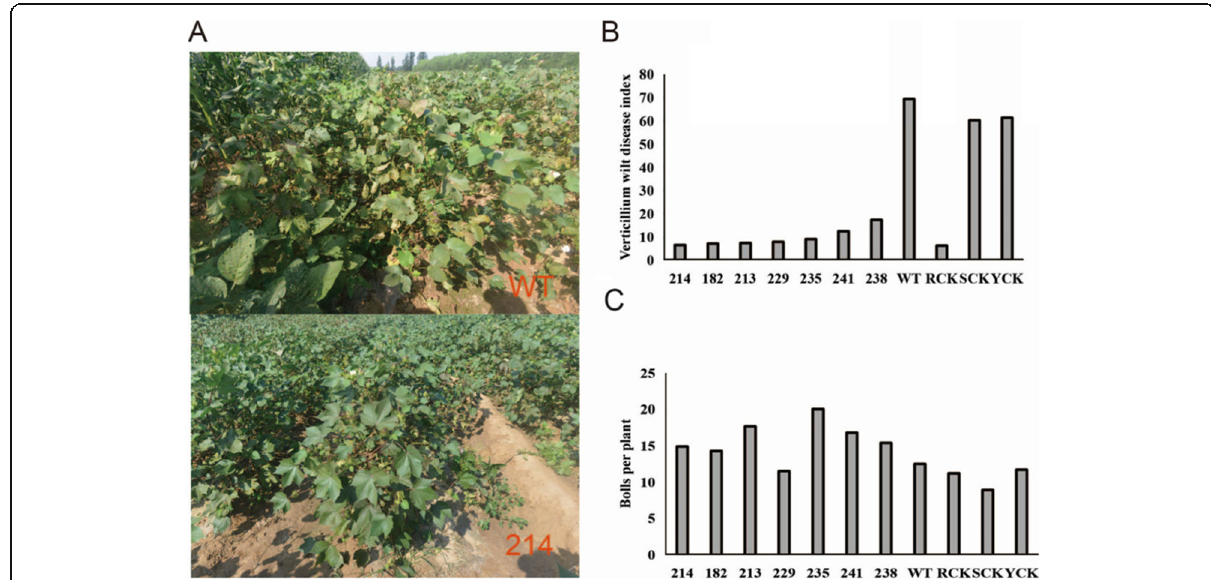
Fig. 5 Disease resistance and yield performance of GbAt11 -overexpressing cotton lines and statistical results. a Boll opening phenotype of transgenic line L-214 and WT in a V. dahliae nursery at the boll opening stage (Shandong, 2013.09). b Morbidity of Verticillium wilt at the flowering and boll-forming stages. The disease index come from the results of August 20. The indexes of L-214 and other lines were significantly lower than those of WT, YCK, and SCK, but similar to RCK. c Bolls per plant at the late flowering and boll-forming stages; several lines, including L- 214, were better than JM169 and